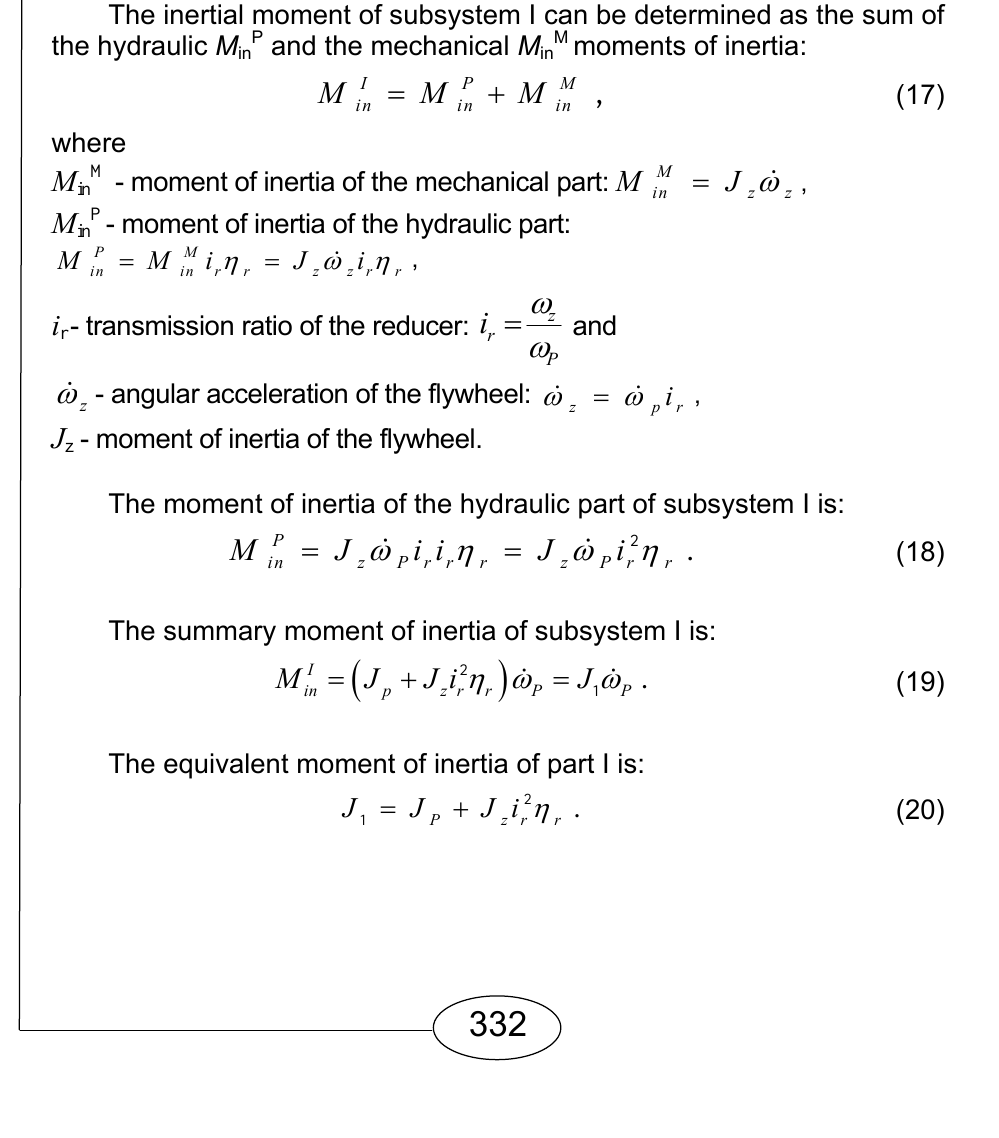
Figure 3 – Subsystem I Рис . 3 – Подсистема I Слика 3 – Подсистем